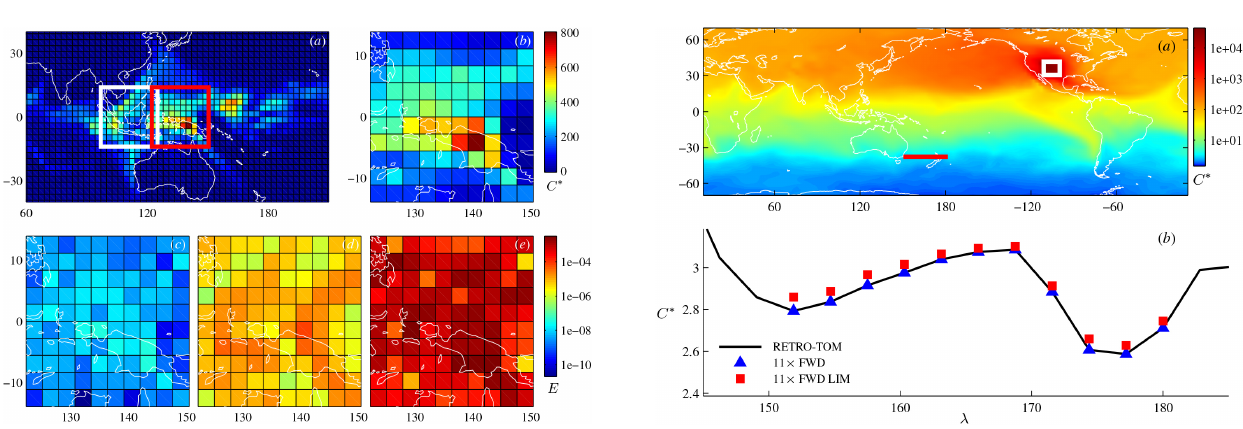
Figure 3. Comparison of sensitivities for test case III. (a) Sensitiv- ity calculated from a single run of RETRO-TOM by Eulerian back- tracking; note the logarithmic colour scale. As before, the white rectangle indicates the location of the receptor region. (b) Sensi- tivity against longitude along the red line shown in (a) ( φ ≈ 38 ◦ S). The solid black line gives C ∗ obtained from RETRO-TOM as previ- ously reported in (a) . The points indicate sensitivities obtained from multiple forward model runs performed both with (red squares) and without (blue triangles) flux